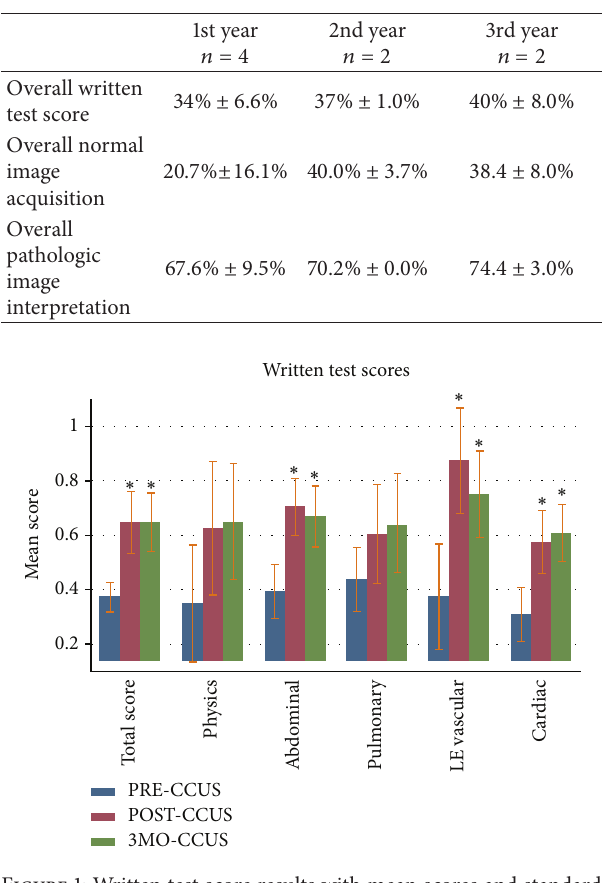
Table 2: Baseline test results for the 1st-, 2nd-, and 3rd-year critical care fellows. Results reported as percent ± SD.